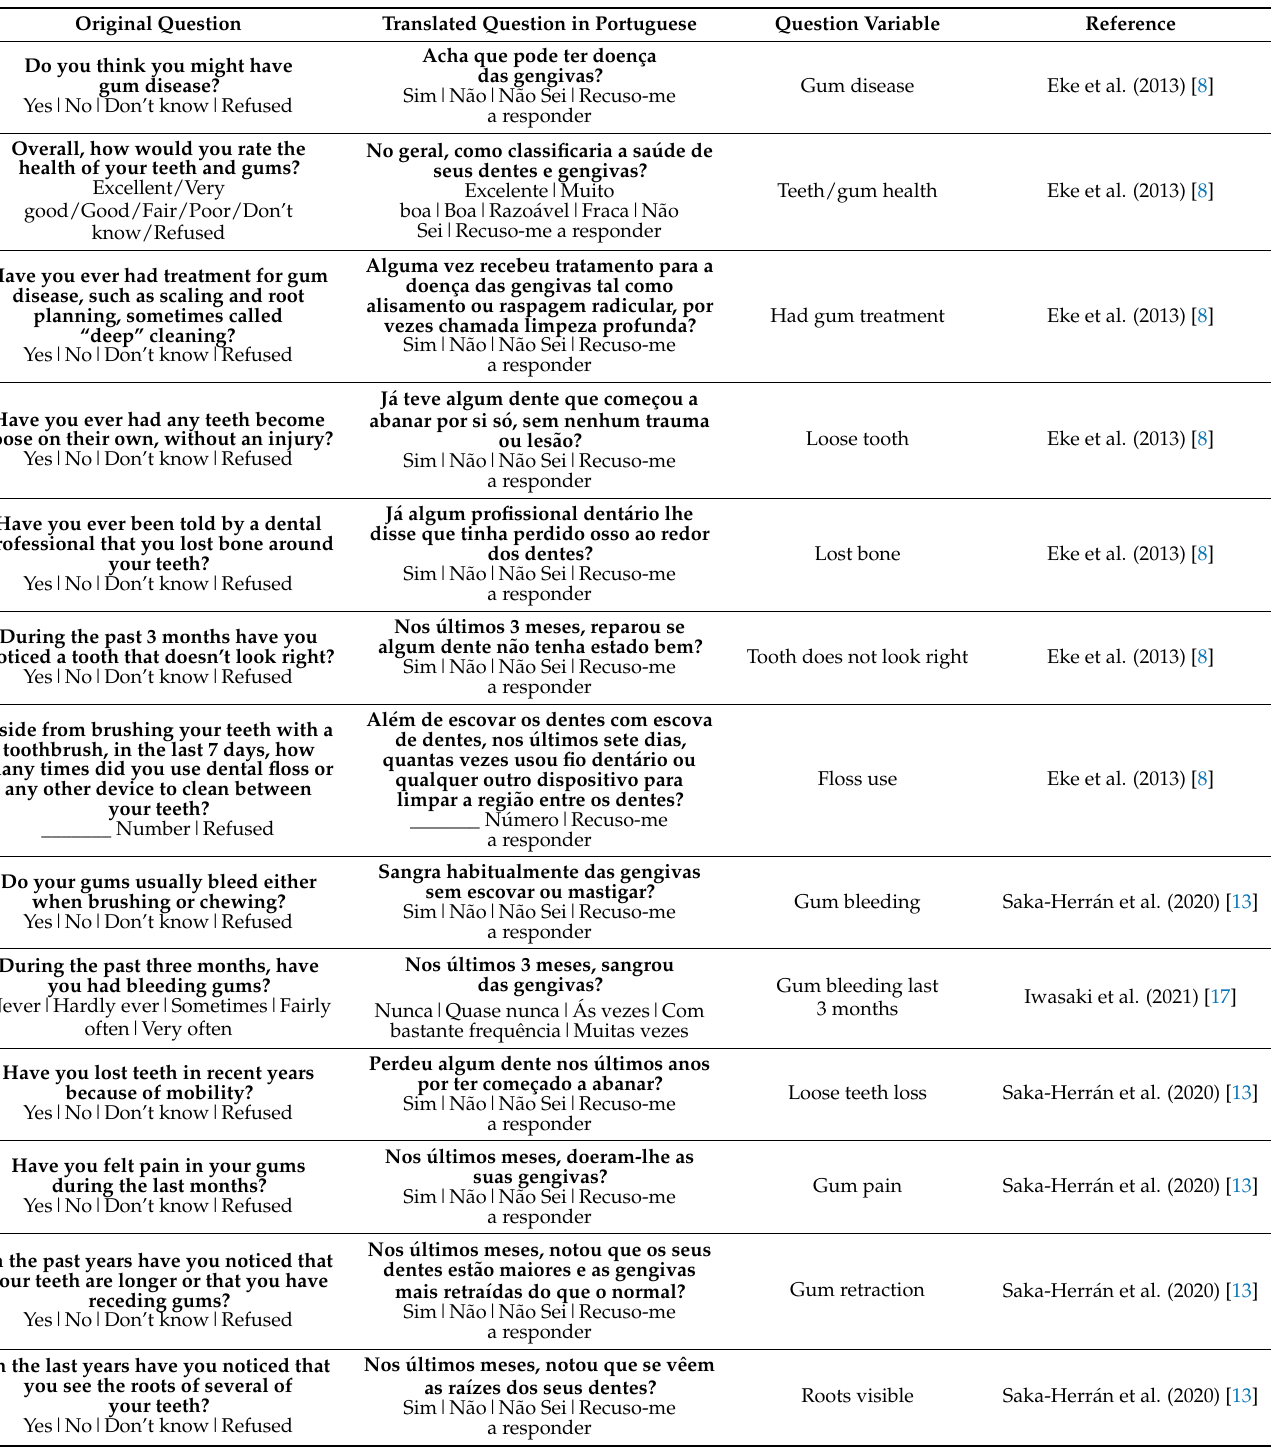
Table 1. Original and Portuguese versions of the self-reported periodontal screening